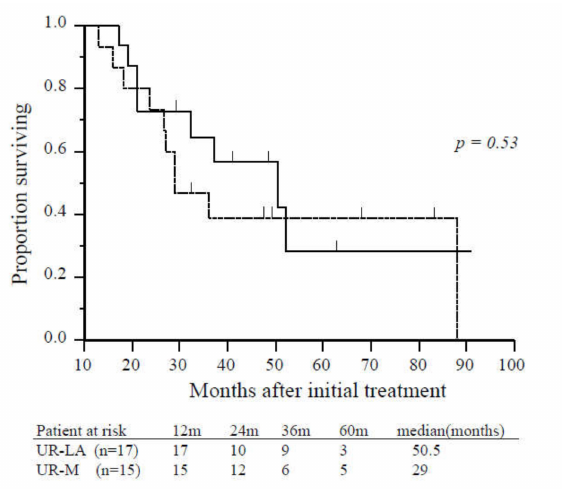
Figure 3. Overall survival of patients with unresectable locally advanced or metastatic disease who underwent conversion surgery. There was no significant di ff erence in overall survival between patients with unresectable locally advanced (solid line, n = 17) and unresectable-metastatic disease (dashed line, n = 15) ( p = 0.53). Abbreviations: UR-LA, unresectable locally advanced; UR-M, unresectable